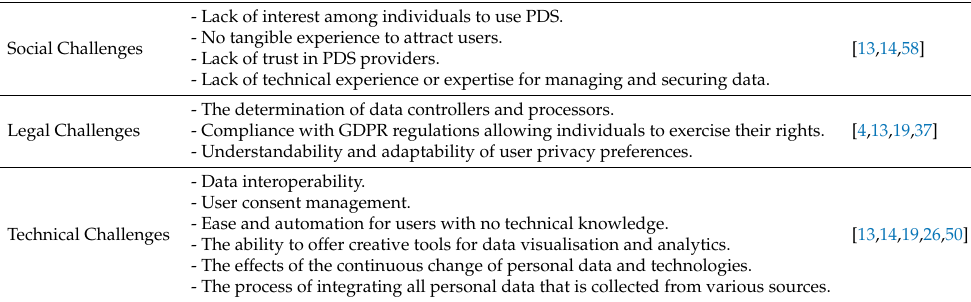
Table 3. Categories of the issues and challenges facing the development of